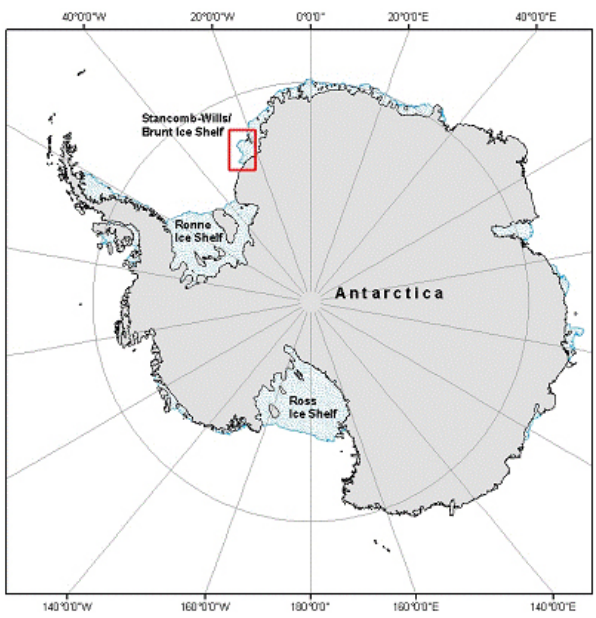
Fig. 1. The location of Brunt Ice Shelf on which the Halley Research Station is located.